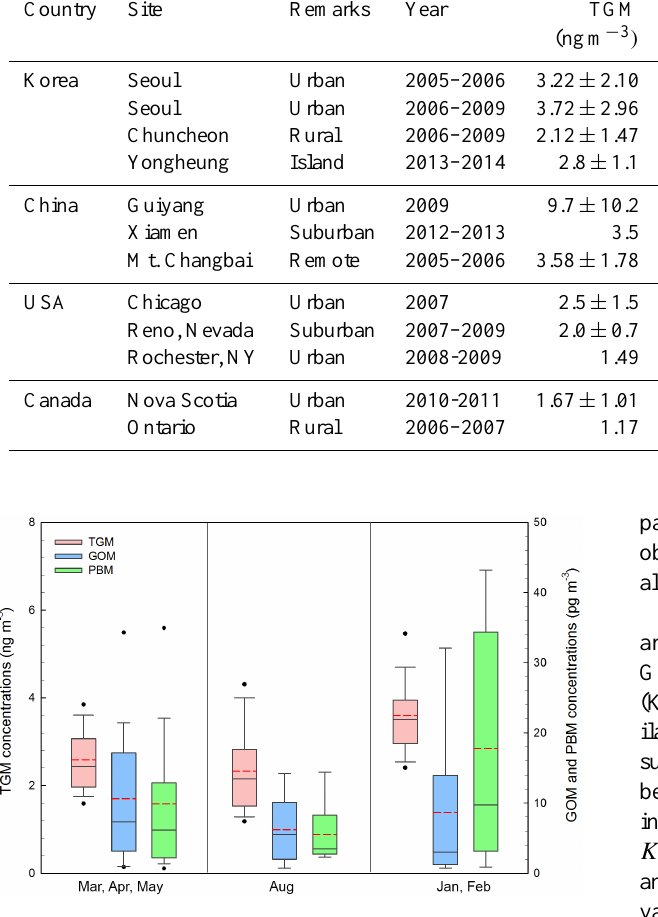
Table 2. Comparisons of measured Hg concentrations with those reported in other studies. Country